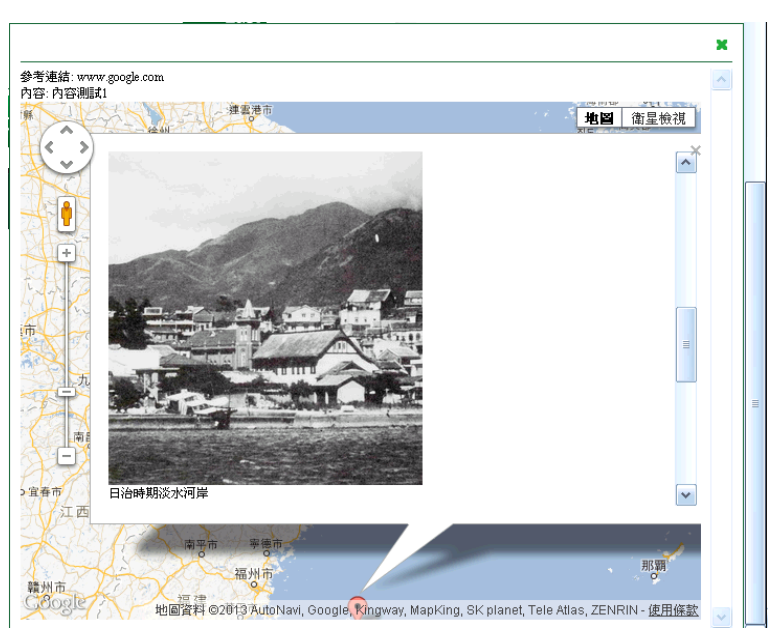
Figure 2. Digital archive information management